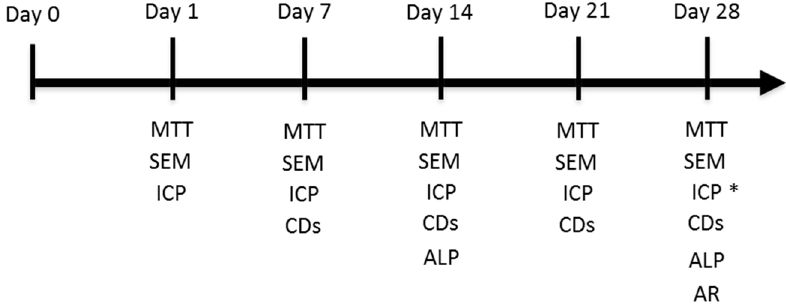
Figure 9. Experimental set-up (* only in GM).